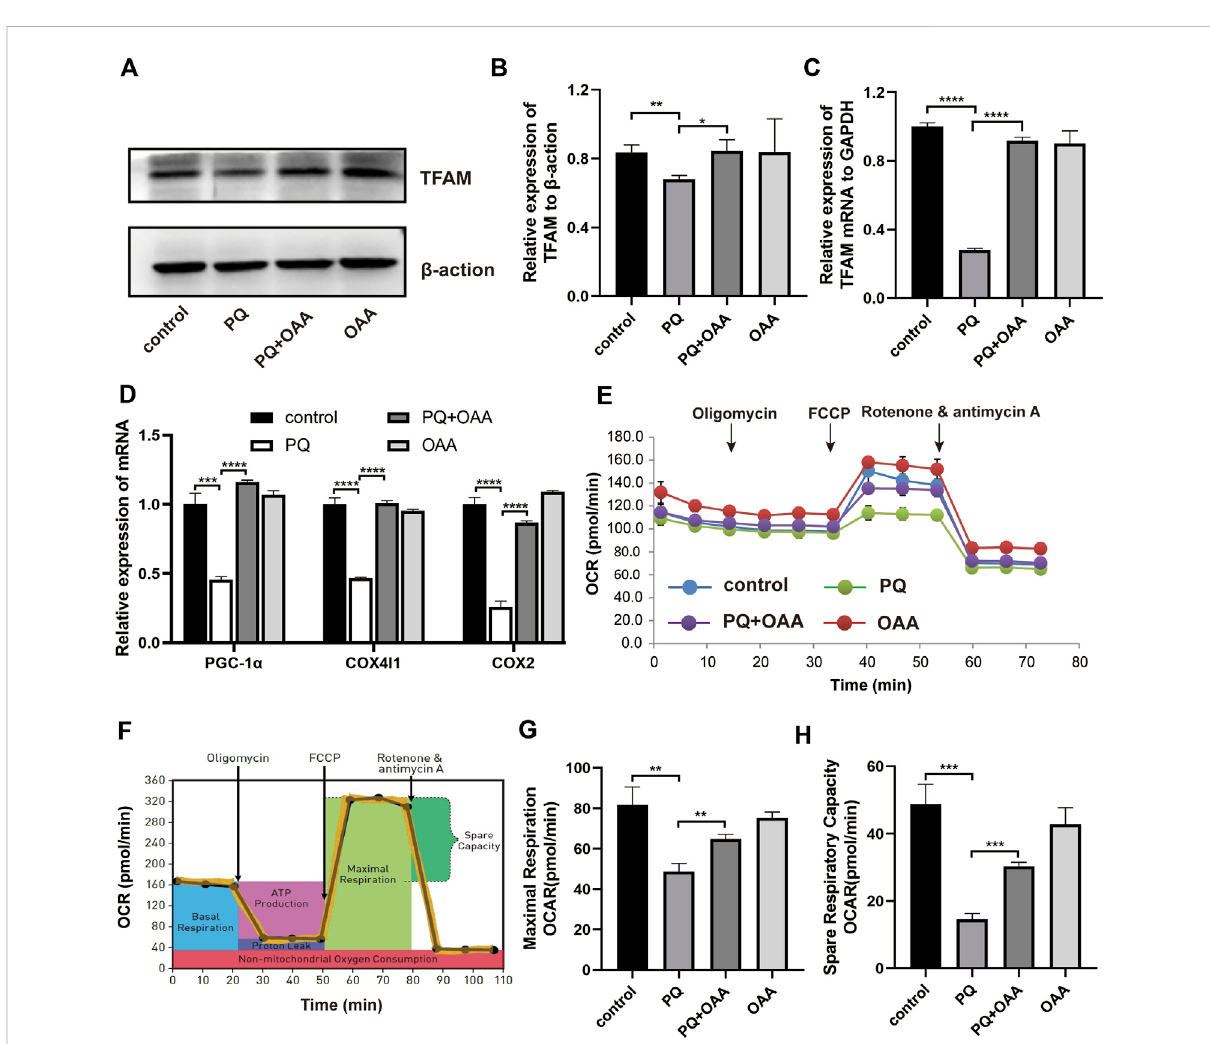
FIGURE 5 OAA promotes mitochondrial biogenesis and alleviates mitochondrial respiration dysfunction caused by PQ in B2B cells. (A,B) The expression levelsofTFAMproteinwasdetectedbyWBassay. (C,D) ThemRNAexpressionlevelsofTFAM,PGC-1 α ,COX4l1,andCOX2wasdetectedbyreal-time PCR assay. (E,F) OCR was detected by mitochondrial stress assay. (G,H) Maximal respiration and spare respiration capacity were calculated after oligomycin and FCCP treatment. Data are presented as mean ± SD ( n = 3). * p ＜ 0.05, ** p ＜ 0.01, *** p ＜ 0.001, **** p ＜ 0.0001. PQ, paraquat; OAA, oxaloacetate acid; OCR: oxygen consumption rate; FCCP, carbonyl cyanide-4 (tri fl uoromethoxy)